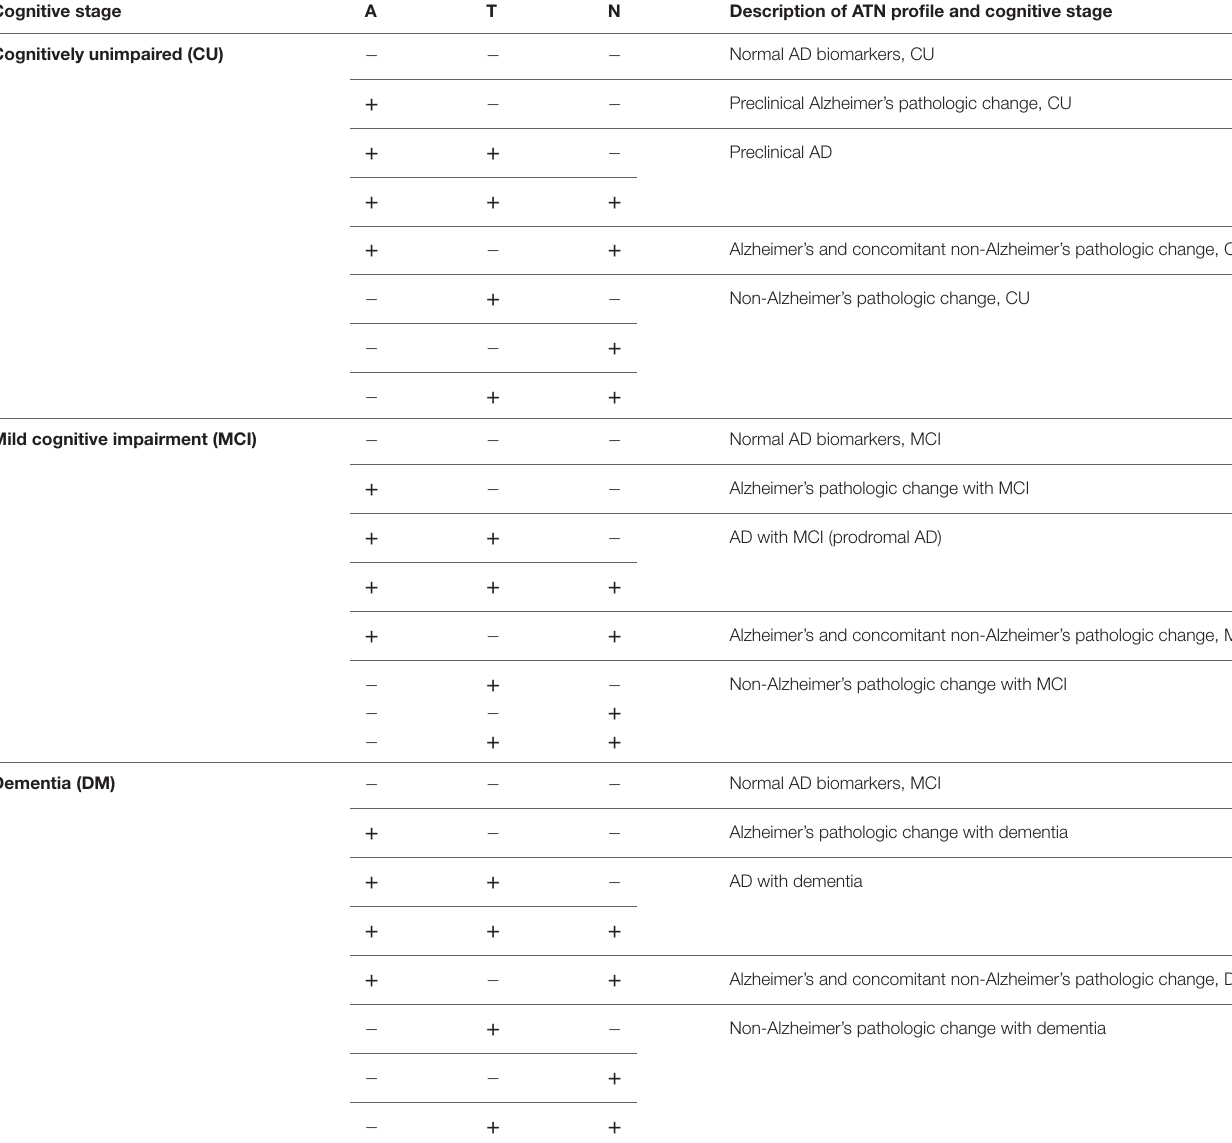
TABLE 1 | Overview of NIA-AA ATN biomarker scores and cognitive staging. Cognitive stage A T N Description of ATN profile and cognitive stage Cognitively unimpaired (CU) Normal AD biomarkers,